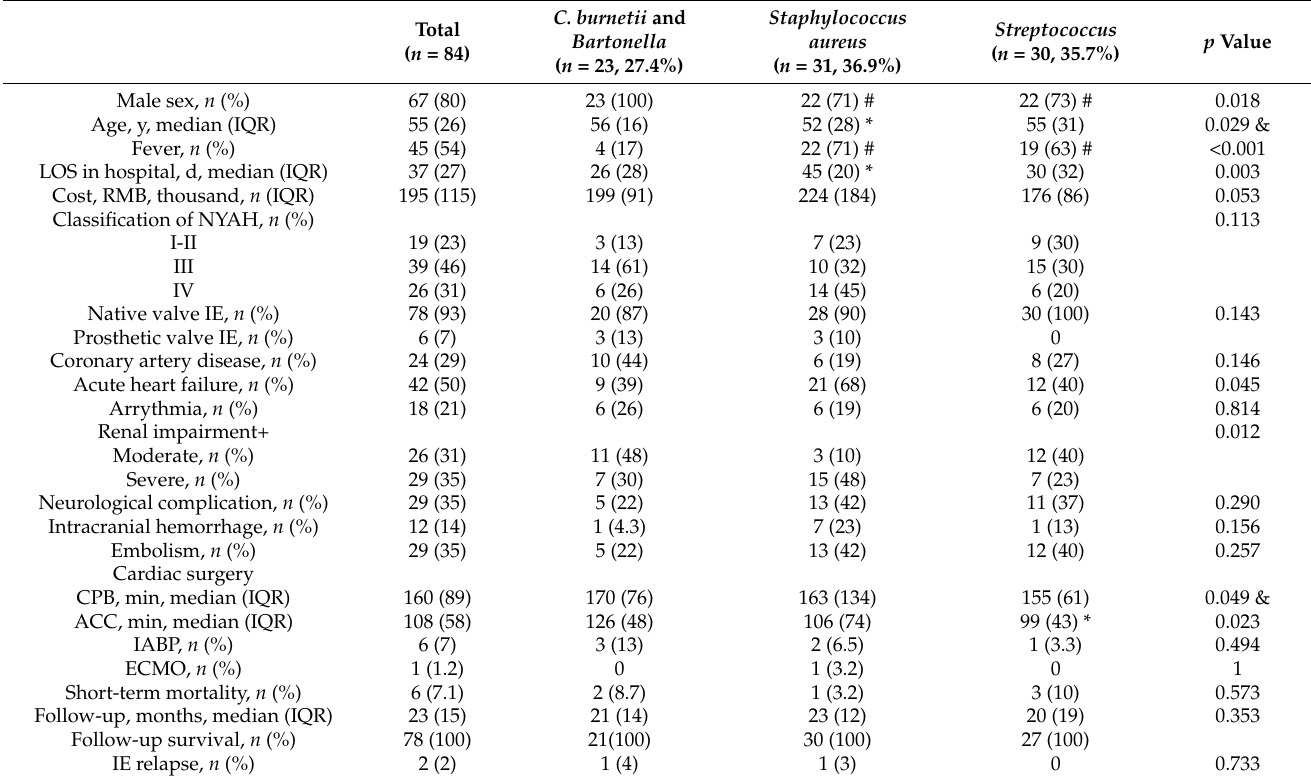
Table 1. Demographic and clinical characteristics of 84